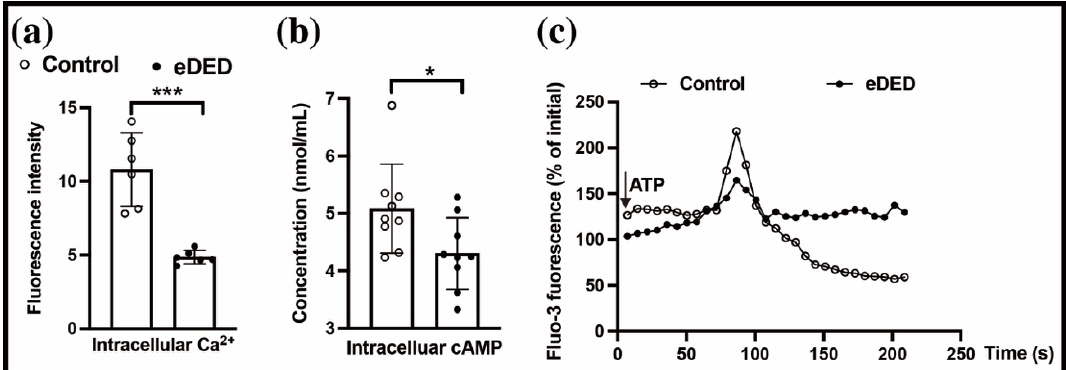
Figure 2. Ca 2+ and cAMP deficiencies in the conjunctiva epithelium of eDED. ( a ) Bar graph showing intracellular Ca 2+ of conjunctiva epithelium in the control and eDED groups (n = 6 in each group). ( b ) Bar graph showing the intracellular cAMP of the conjunctiva epithelium in the control and eDED groups (n = 9 in each group). ( c ) Line graph showing the intracellular Ca 2+ of conjunctiva epithelium after ATP treatment in the control and eDED groups (n = 6 in each group). Data are represented as mean ± SEM. * p < 0.05, *** p < 0.001.